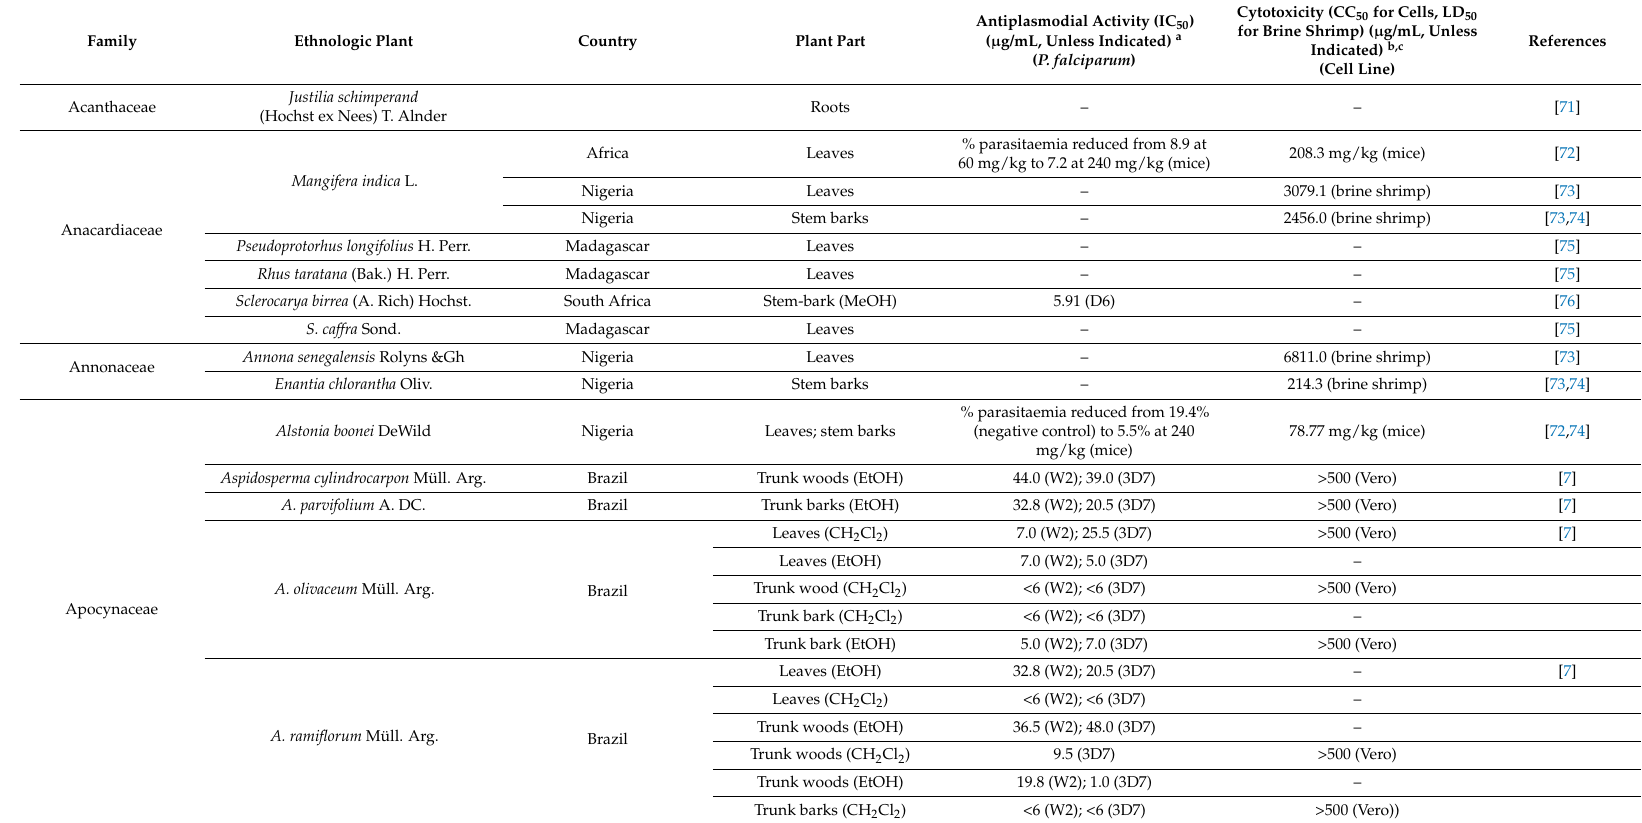
Table 3. The ethnology of